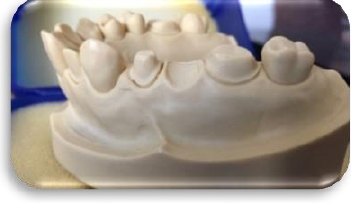
Figure 1: Model from ivoclar with prepared maxillary first molar and maxillary first premolar to simulate three- unites